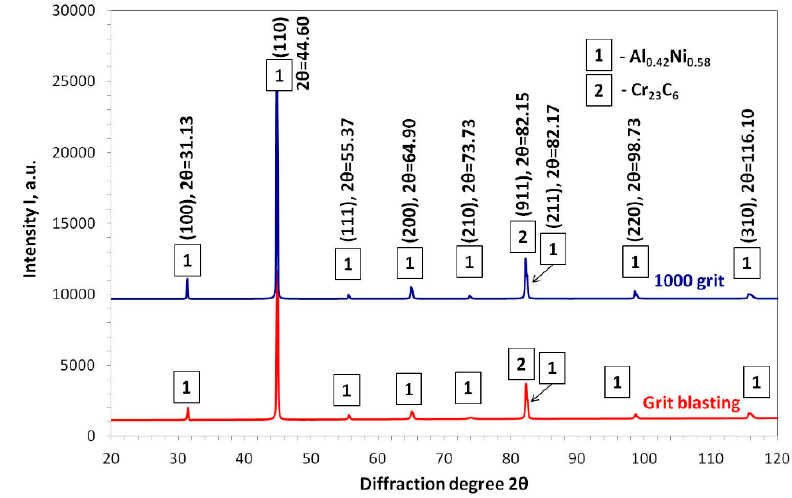
Figure 10. XRD patterns obtained from aluminized IN 738 with ground and grit-blasted surfaces in the as-received condition.